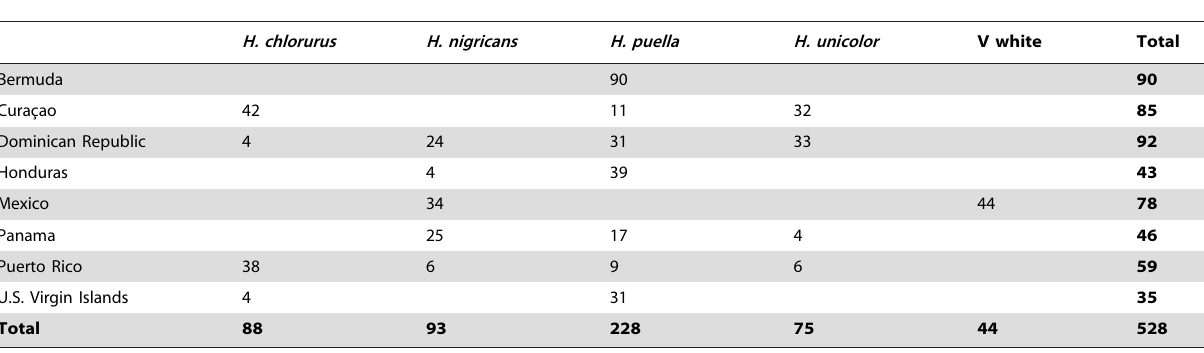
Table 1. Hypoplectrus samples collected for AFLP